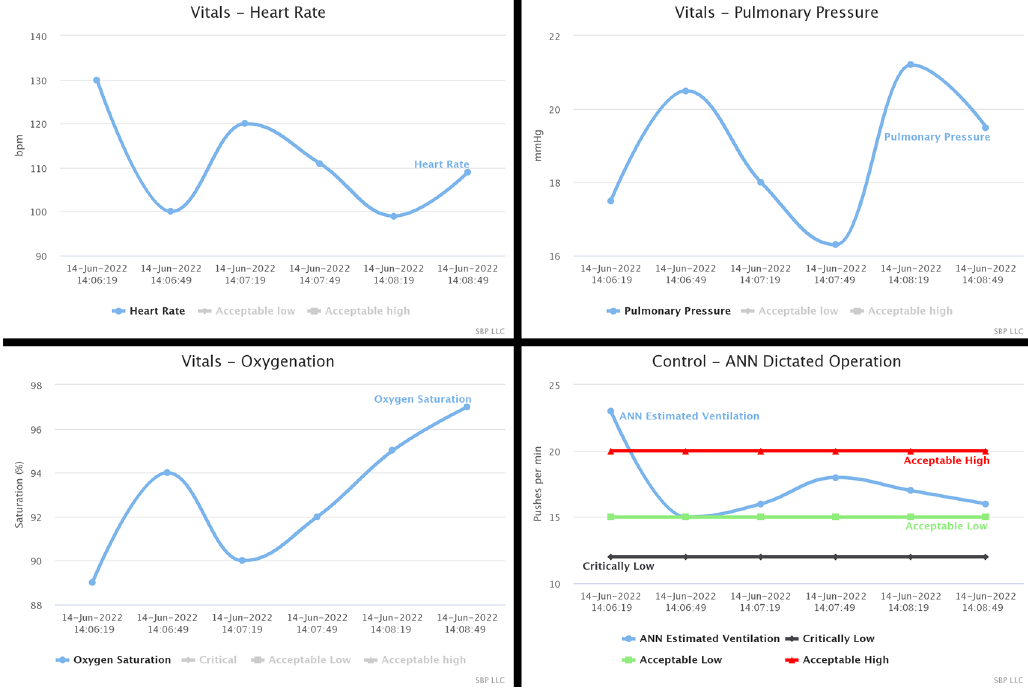
Figure 7. Evalu@ displaying vitals and the control signal in the timeline. The vitals are presented without alarm levels.Thecontrolsignalhasallthelevelsactivated.Itgeneratesmailalarms – inadditiontothosegeneratedin-site – when the control signal is above or below the established